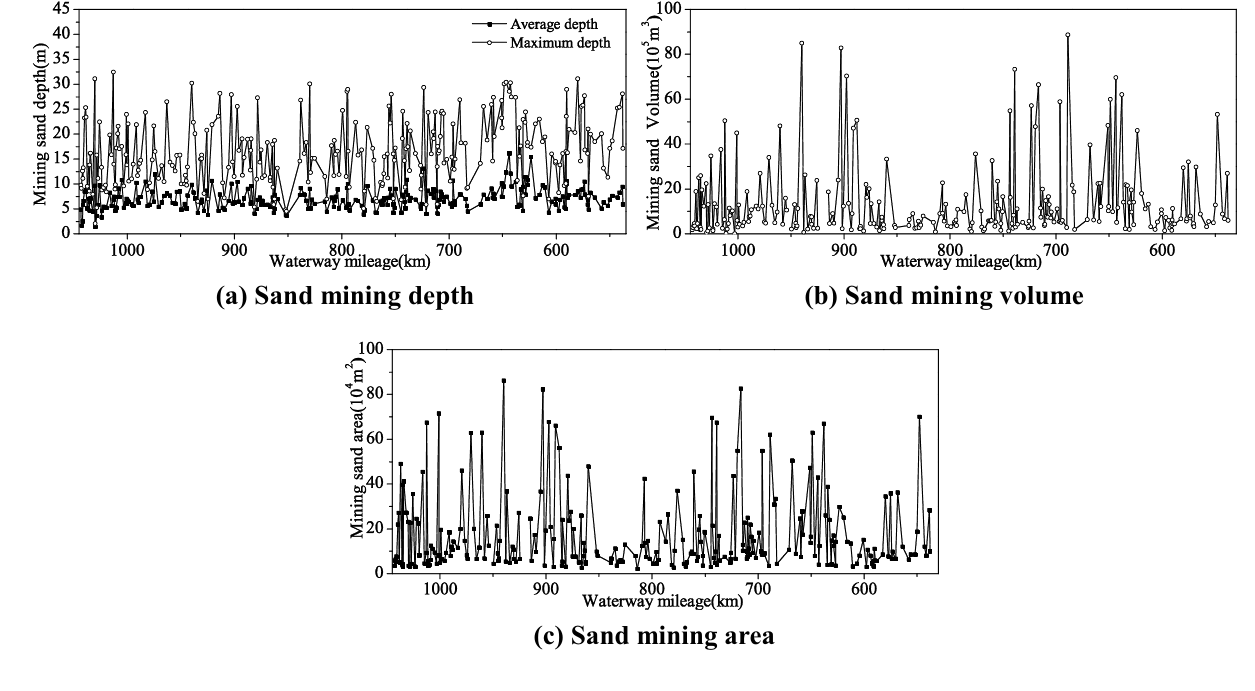
Fig. 19 Sand mining